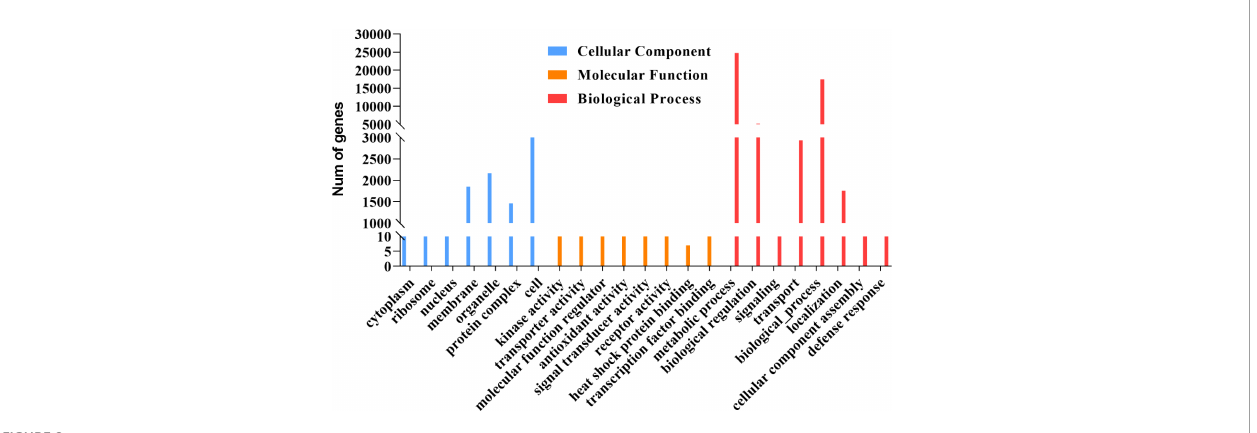
FIGURE 2 GO secondary function analysis 8291 transcripts are translated in grapes. The blue bar chart represents a cellular component, the orange bar chart represents a molecular function, red bar chart represents the molecular